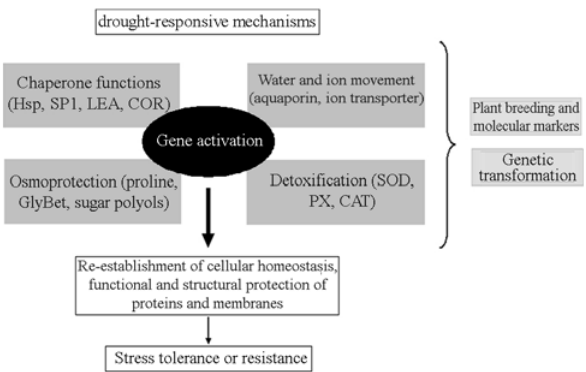
Figure 8 - Drought responsive mechanisms in plants leading to acquired stress tolerance. Stress-responsive mechanisms reestablish homeostasis, protect and repair damaged proteins and membranes. Genetic engineering and conventional plant breeding combined with the use of molecular markers and quantitative trait loci (QTLs) provide invaluable tools to achieveacquiredtolerancetoabioticstress.Abbreviations:CAT,catalase; CDPK, calcium-dependent protein kinase; COR, cold-responsive protein; Hsp, heat shock protein; LEA, late embryogenesis abundant; PX, peroxidase; ROS, reactive oxygen species; SOD, superoxide dismutase; SP1, stable protein